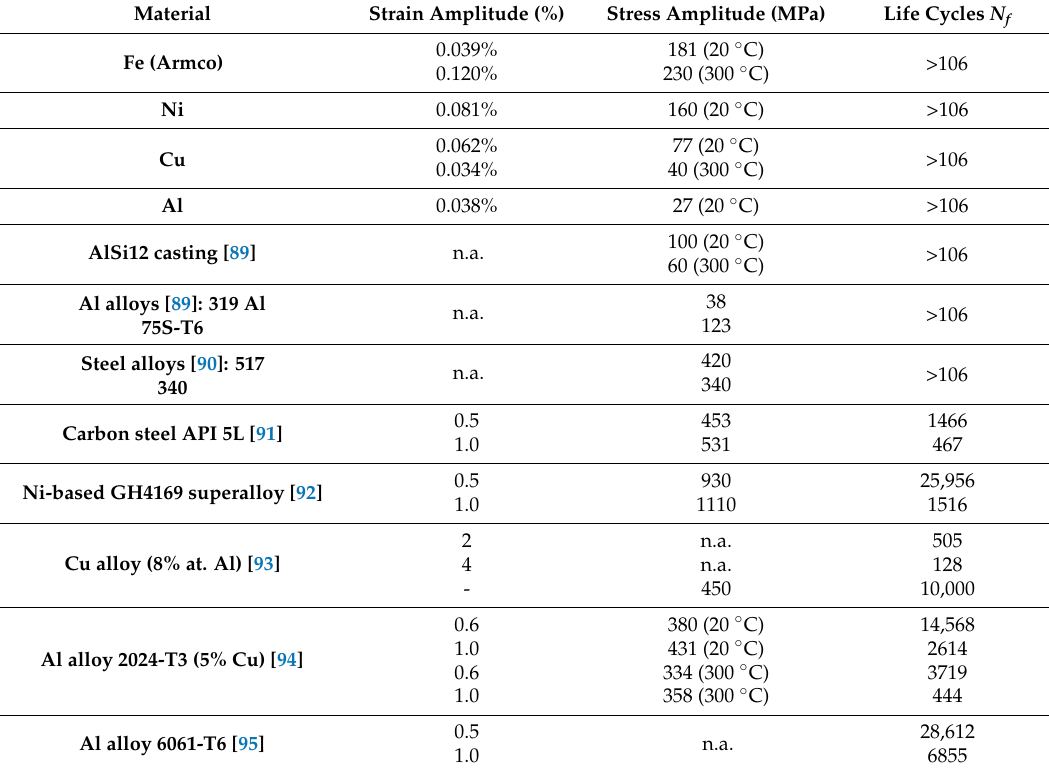
Table 4. Fatigue properties of pure metals and alloys including life cycle N f at different strain and stress